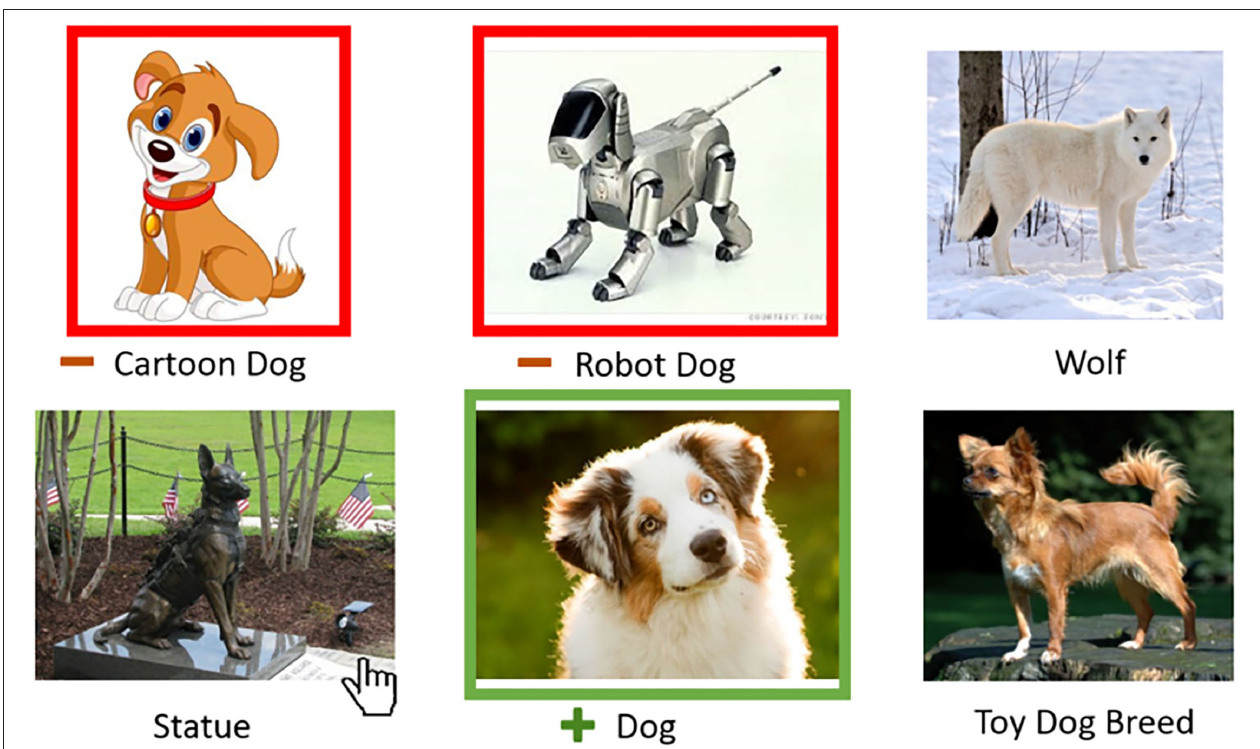
FIGURE 3 | For Stage 2 (RESOLVE), our interface design lets a requester easily select and label images. Each mouse click on an example toggles between unselected, selected positive, and selected negative